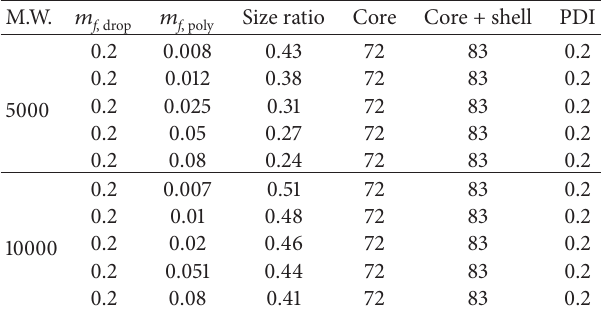
Table 1: The results of analyzing the SAXS experiments with hard sphere depletion model that is explained in the text; PDI is E polydispersity of PCL/C 12 5